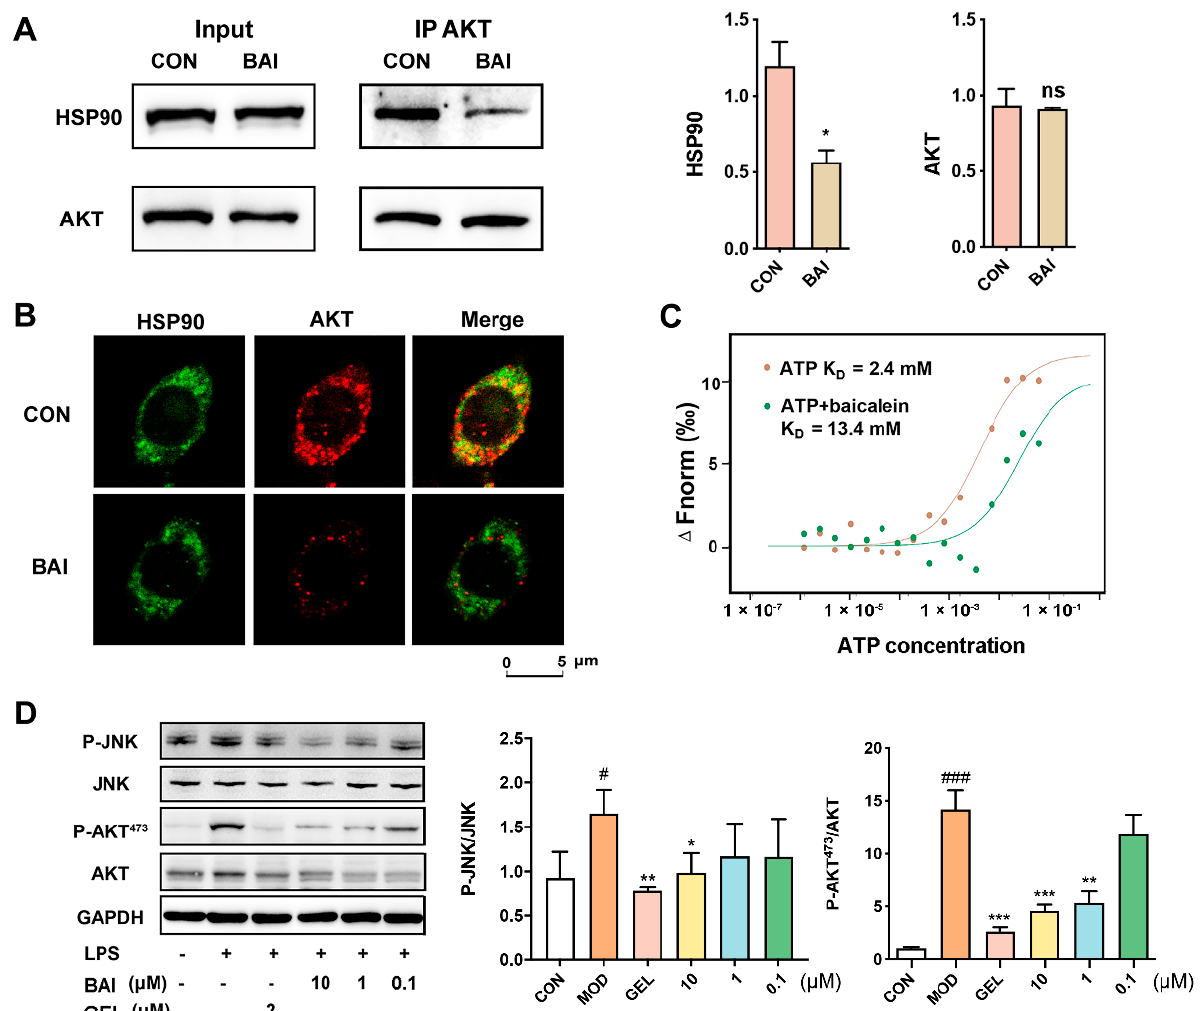
Figure 2. BAI bound to the ATP-binding domain of HSP90 to induce AKT degradation. ( A ) Co-IP of the HSP90 and AKT proteins with or without BAI ( n = 3). * p < 0.05 vs. CON group. ( B ) Co-localization of HSP90 (pseudo-red) with AKT (pseudo-green) with or without 10 µ M BAI administration in RAW264.7 cells. ( C ) BAI competing with ATP to target HSP90 measured using MST. ( D ) BAI reduced the expression of P-JNK and P-AKT stimulated using LPS in RAW264.7 cells in a concentration-dependent manner ( n = 3). # p < 0.05, ### p < 0.001 vs. CON group; * p < 0.05, ** p < 0.01 and *** p < 0.001 vs. MOD group; ATP, adenosine triphosphate; BAI, baicalein; CON, control; GEL, geldanamycin; HSP90, heat shock protein 90; LPS, lipopolysaccharide.